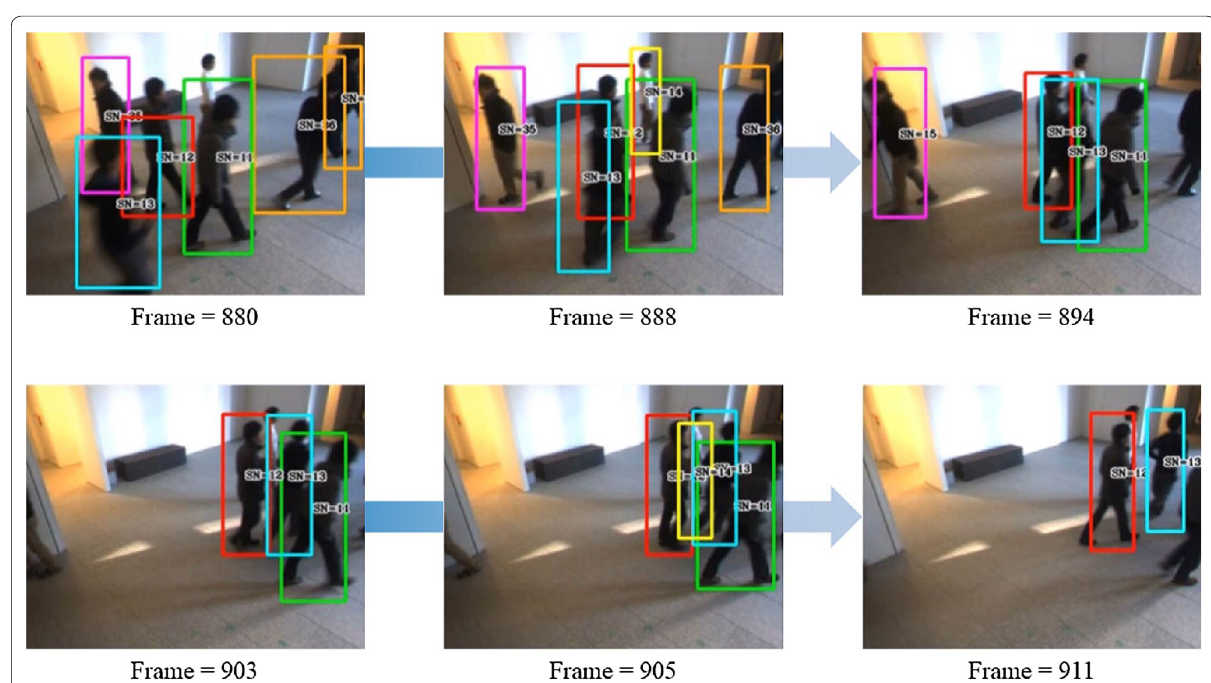
Fig. 14 Tracking scenes of a running